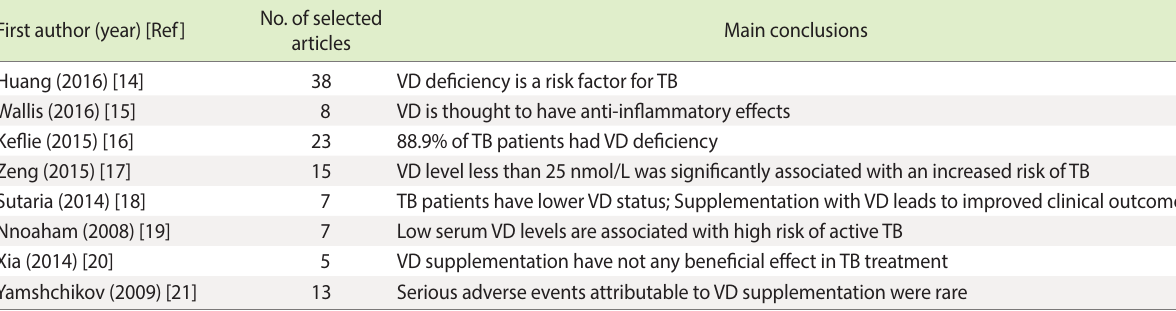
Table 1. Main conclusions of systematic reviews associated with VD level and activation of